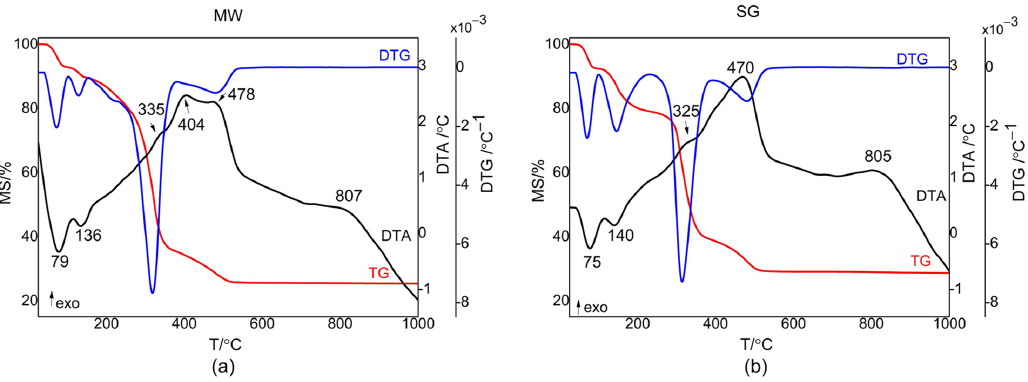
Figure 1. ATD, DTG, and TG curves for the V doped ZnO gels obtained by: ( a ) microwave assisted sol–gel method (MW), ( b ) sol–gel method (SG).